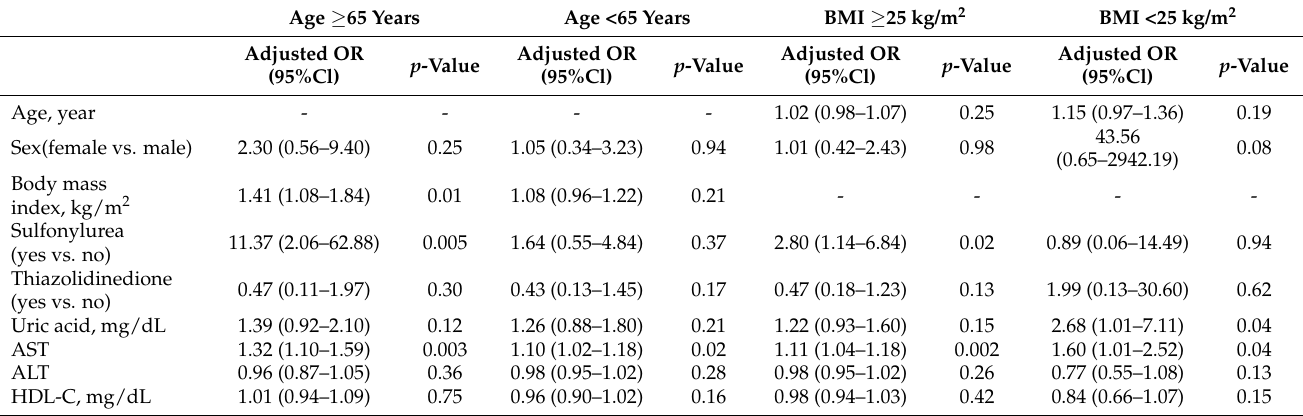
Table 3. Adjusted risk factors for liver fibrosis in T2D patients with NAFLD stratified by Age and